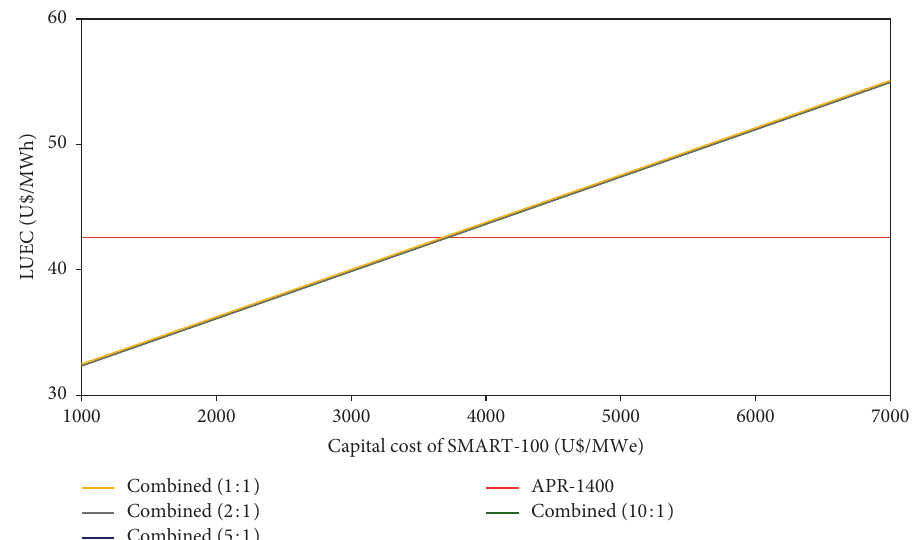
Figure 22: Variations in the LUECs of the combined nuclear fleet (APR-1400 and SMART-100) with different compositions of reactor designs and varying capital cost of the SMART-100 reactor. Numbers in parenthesis ( X : Y ) represent the composition of reactor designs (i.e., X units of APR-1400 and Y units of SMART-100).